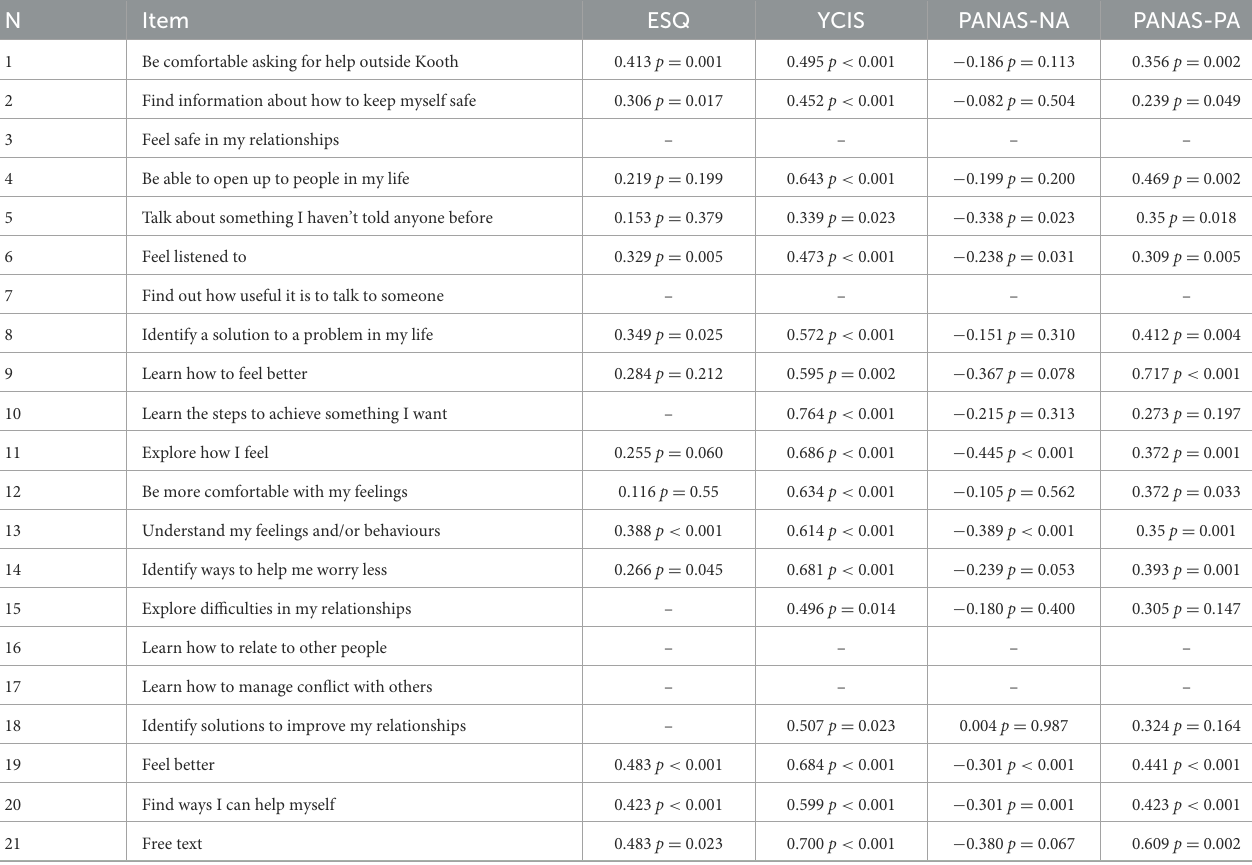
TABLE 6 Pairwise Spearman-ranked correlations between individual SWAN-OM items and YCIS, ESQ, and PANAS total scores a − c . N